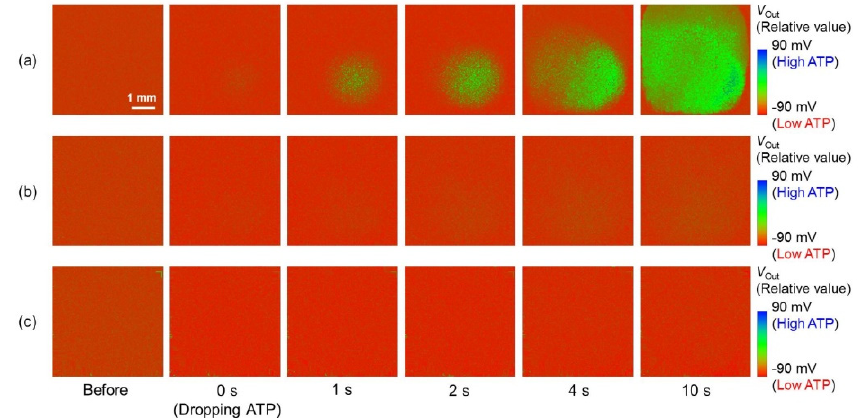
Figure 6. Temporal change in the output images after the addition of ATP solution. ATP concentration is 1 mM. ( a ) The output image to ATP measured by the enzyme − immobilized sensor, ( b ) the output image of the enzyme − immobilized sensor measured in no glycerol, and ( c ) the output image of an enzyme − free sensor.